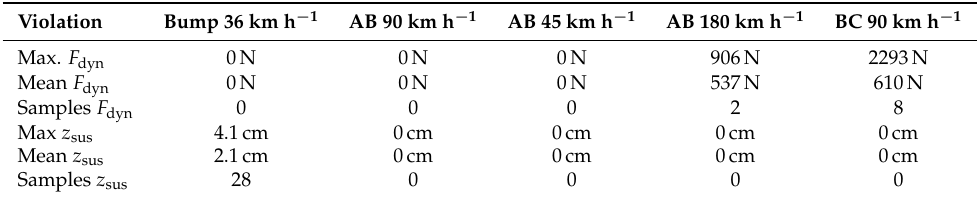
Table A1. Constraint violations in the passive simulations.